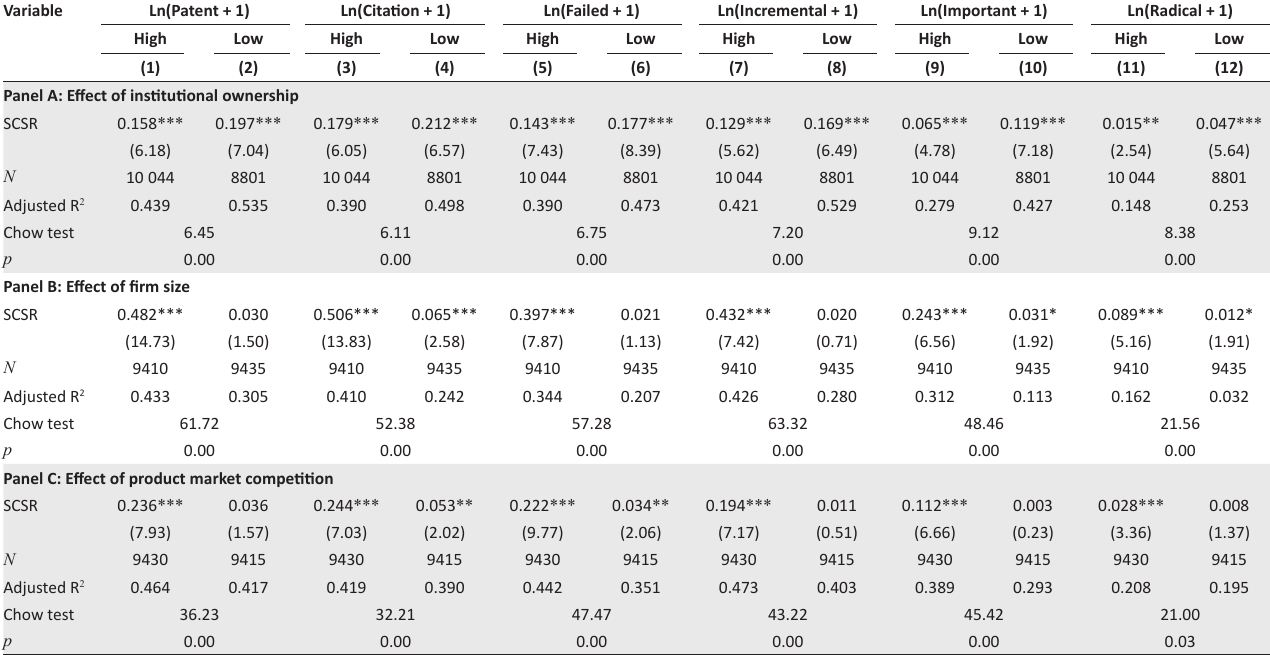
TABLE 6: Cross-sectional heterogeneity.